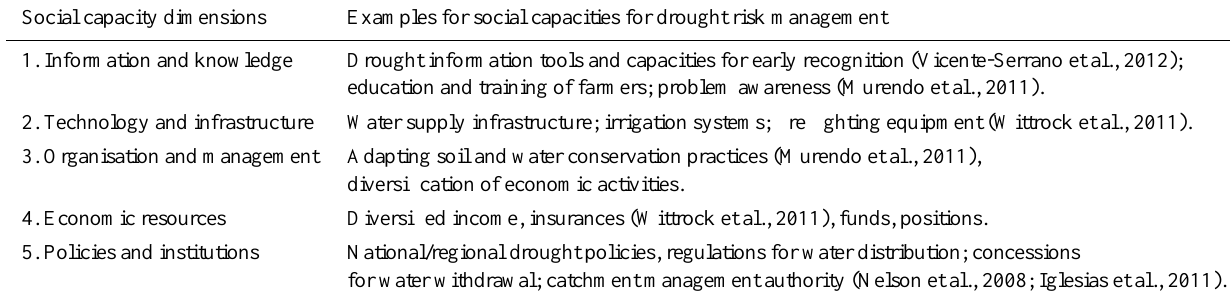
Table 1. General social capacities for drought risk